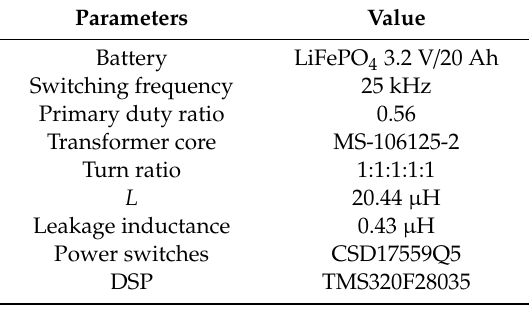
Table 2. Experimental parameters. DSP: digital signal processor.